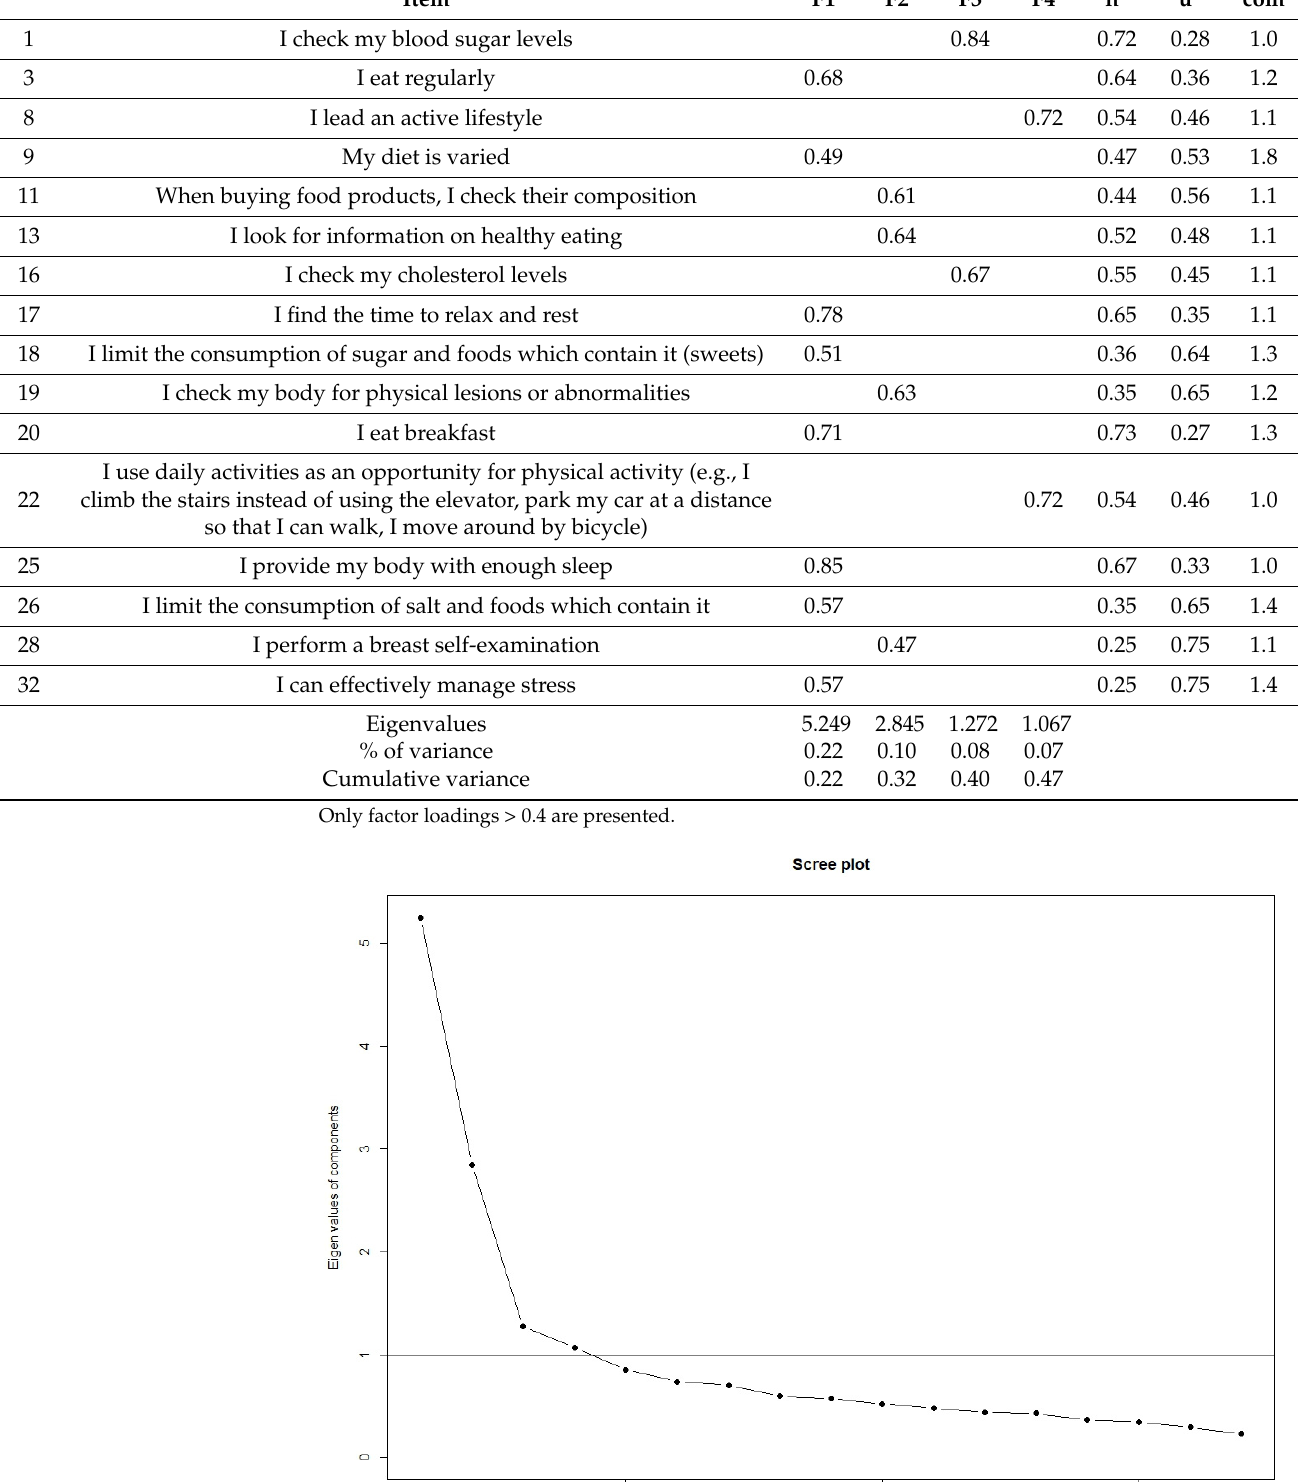
Table 1. Factor Loadings and Item Communalities by EFA (n = 487).